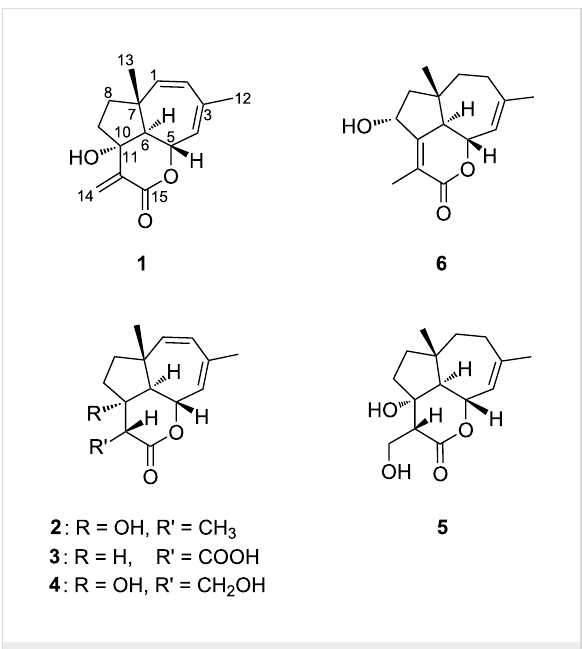
Figure 1: Structures of fulvoferruginin ( 1 ) and the newly isolated deriv- atives fulvoferruginins B–F ( 2 – 6 ).